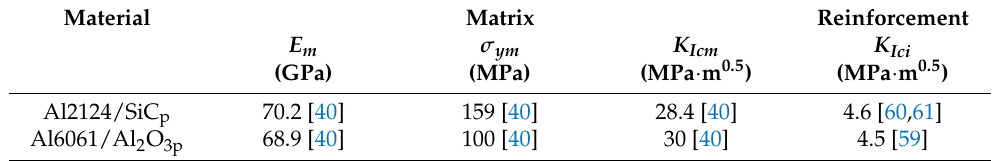
Table 4. Mechanical parameters of matrix and reinforcement materials used in MMCs.